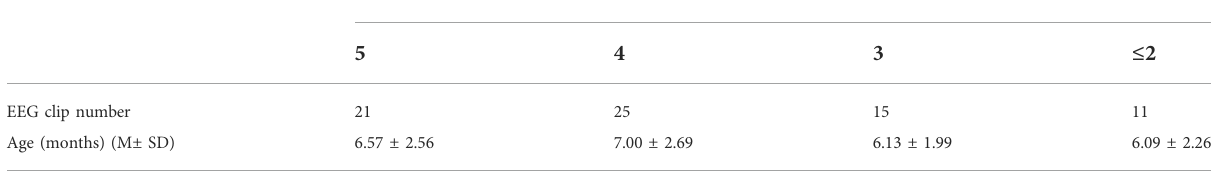
TABLE 1 BASED score for EEG clips